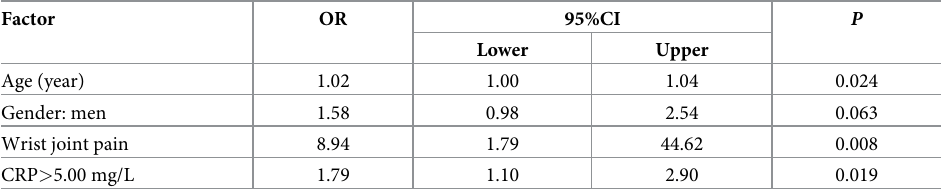
Table 5. The relevant factors of positive RF in 445 brucellosis patients with